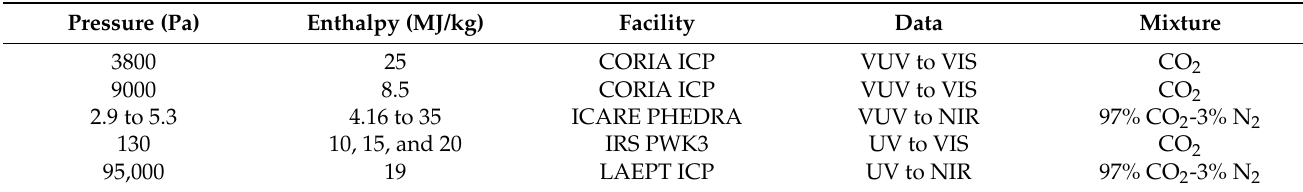
Table 9. Test conditions investigated in some European plasma